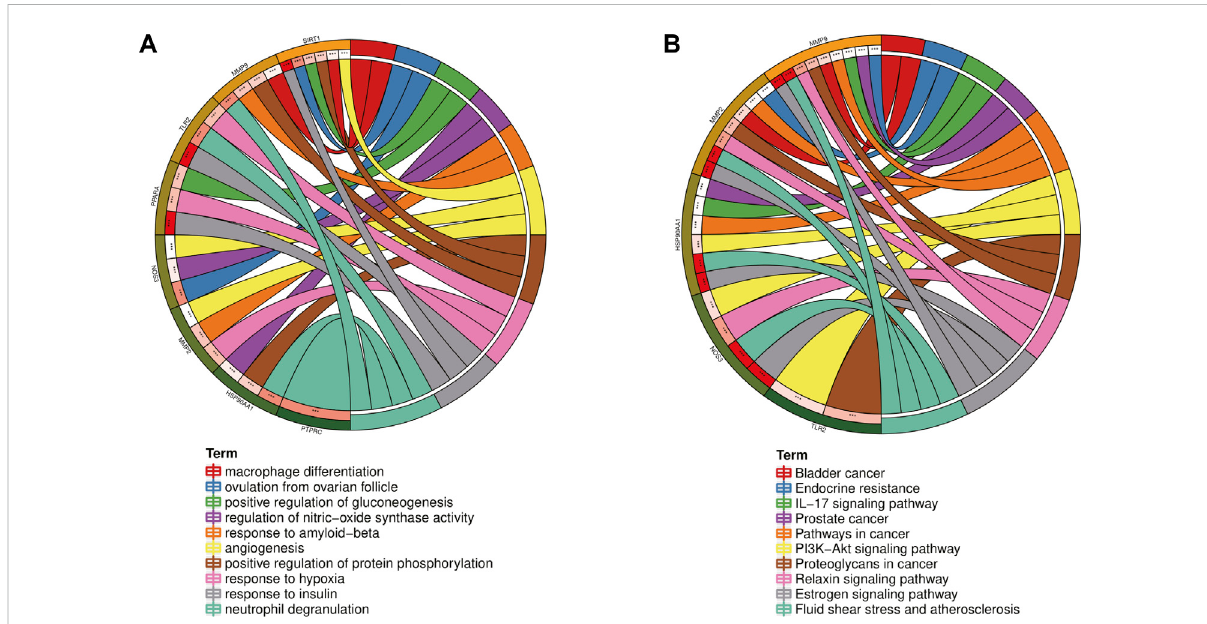
FIGURE 6 GOandKEGGenrichmentanalysisoftheHubgeneshowedthetop10enrichmentdata. (A,B) The outermost partoftheCircrocircle showsthe genes of the fi rst ten enrichment items, and the inner circle on the left represents the signi fi cant p -value of the corresponding gene pathway.